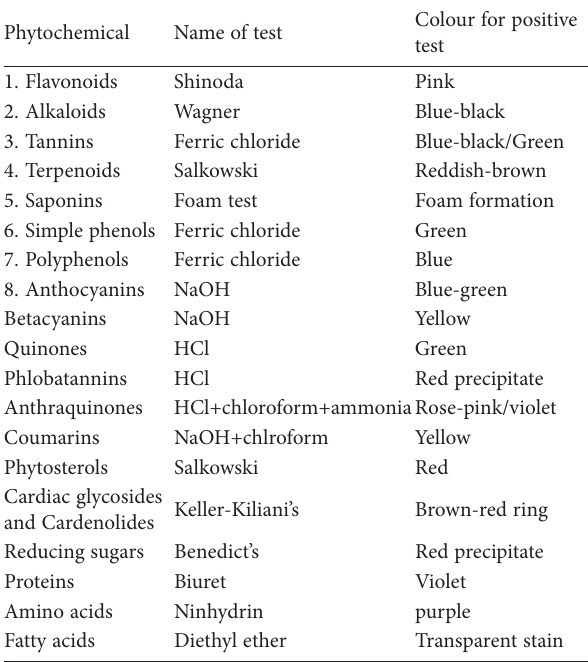
Table 1. Phytochemical screening